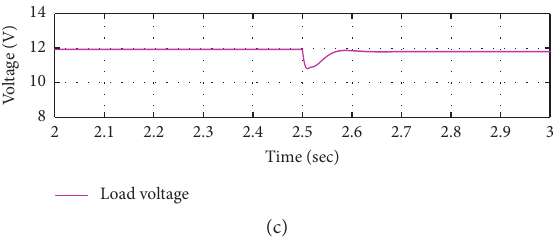
Figure 11: Simulation results for the proposed algorithm with an increase in the load. (a) The output voltage of converter I. (b) The output voltage of converter II. (c) The voltage at the common DC bus.